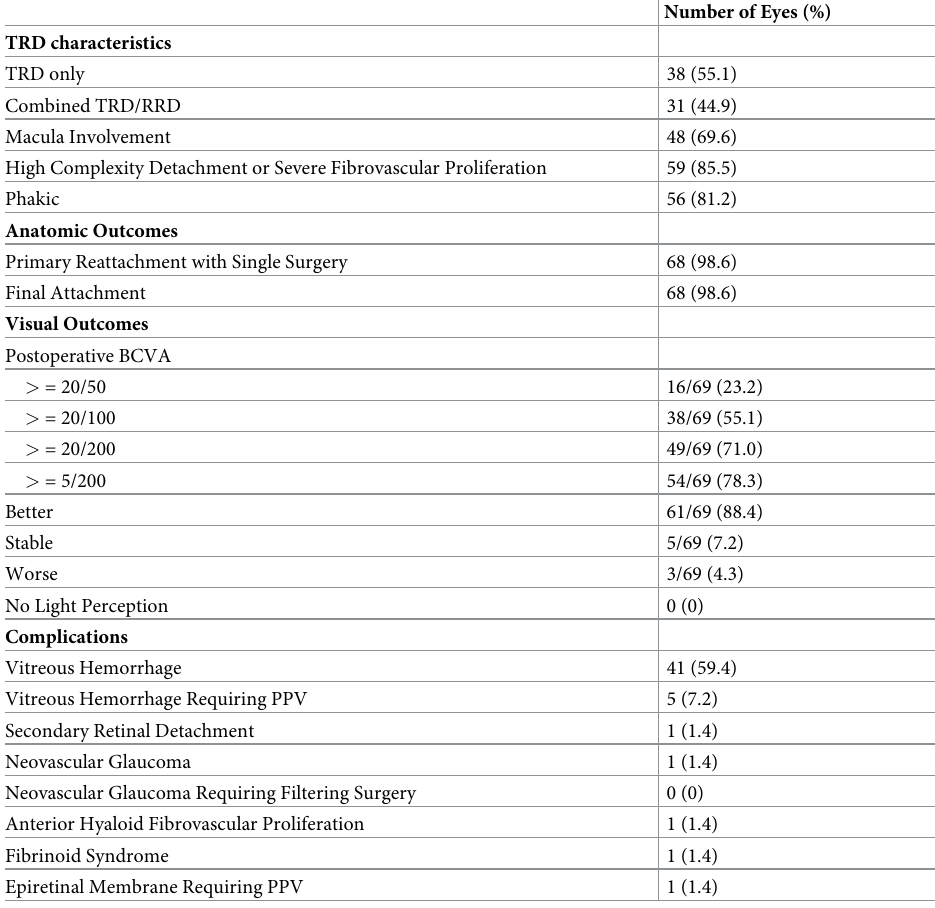
Table 2. TRD characteristics, anatomical and functional outcomes, and complications (n =